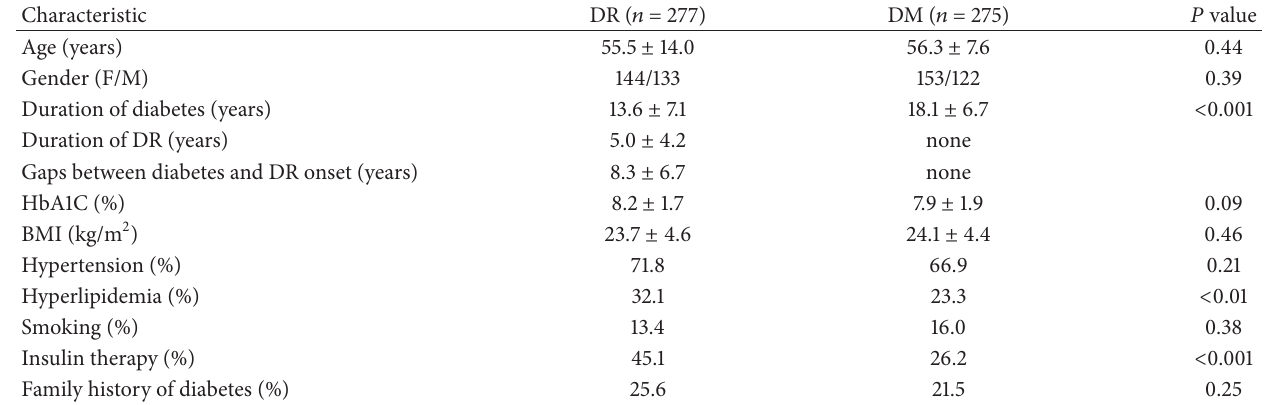
Table 1: Demographic and clinical characteristics of the study subjects.